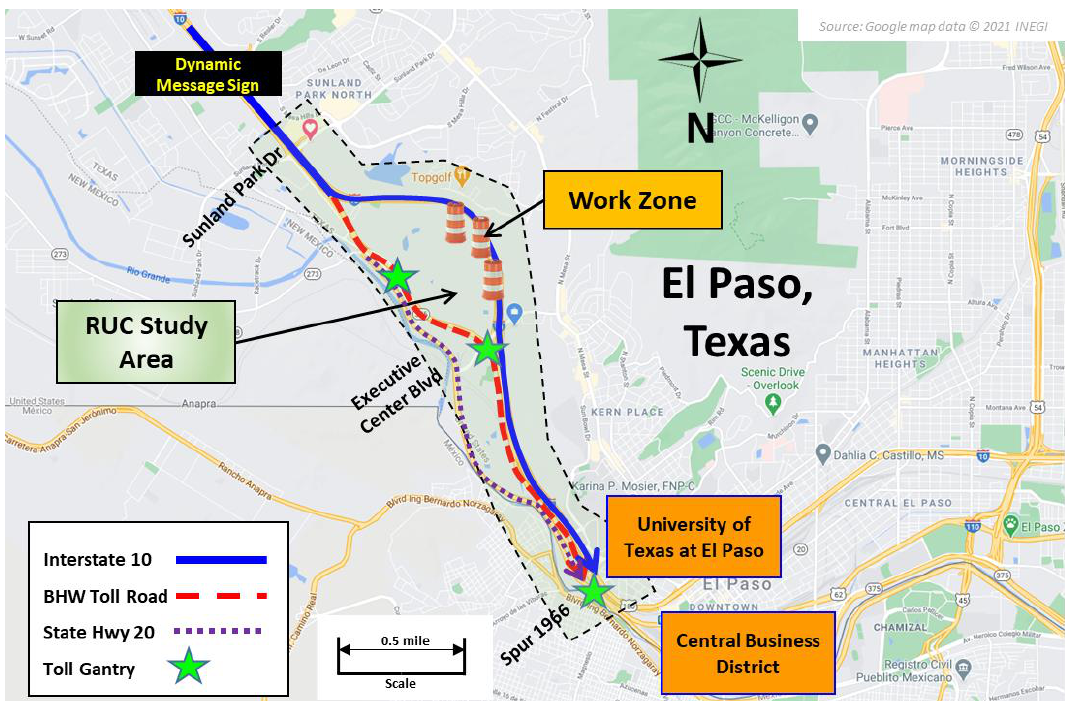
Figure 5: I-10 work zone